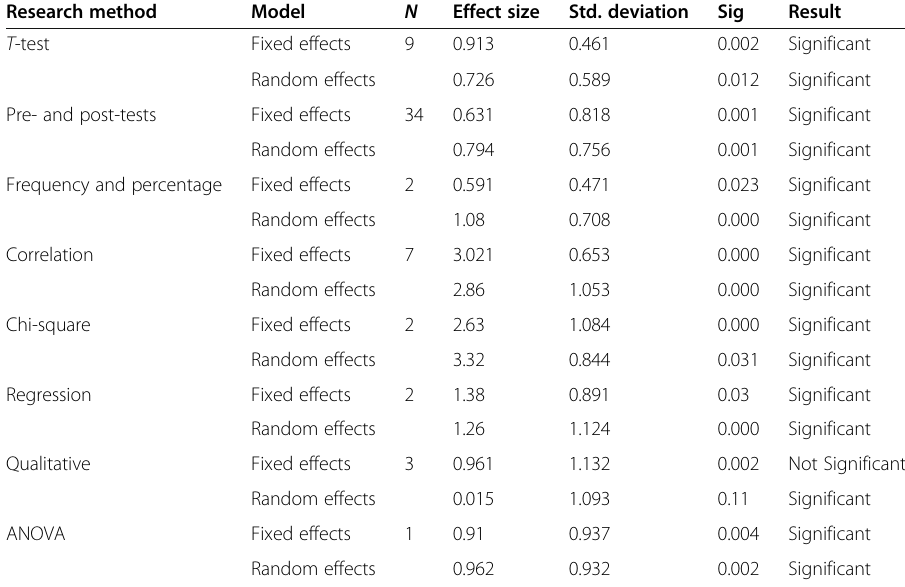
Table 11 Effect size by research method Research method